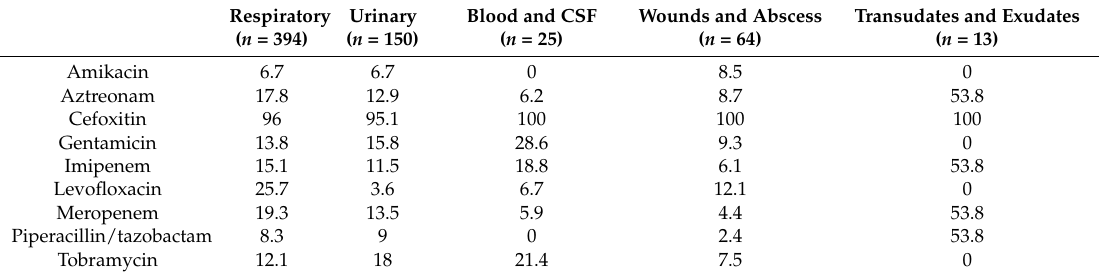
Table 2. Five-year percentage antibiotic resistance of P. aeruginosa with respect to specimen source.